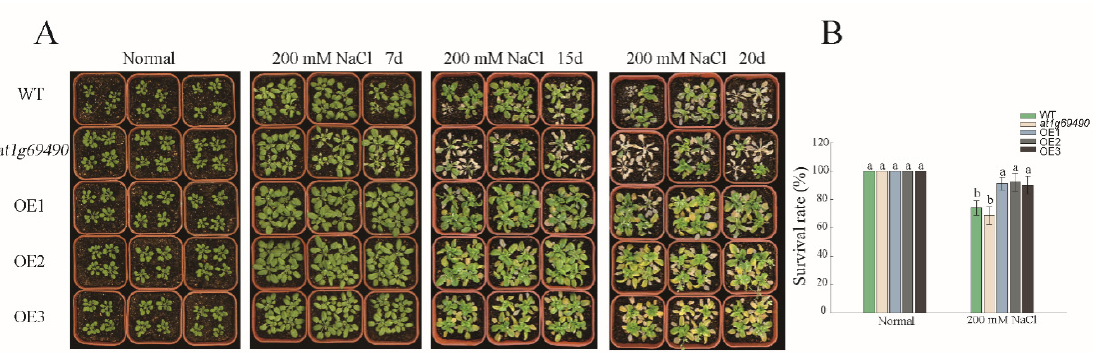
Figure 6. Overexpression of PwNAC38 significantly improved salt tolerance in the adult phase. ( A ) Phenotype experiments of different lines after NaCl treatment. ( B ) Statistics of survival rates under salt stress. The significantly different mean values at p ≤ 0.05 were labeled by different letters.